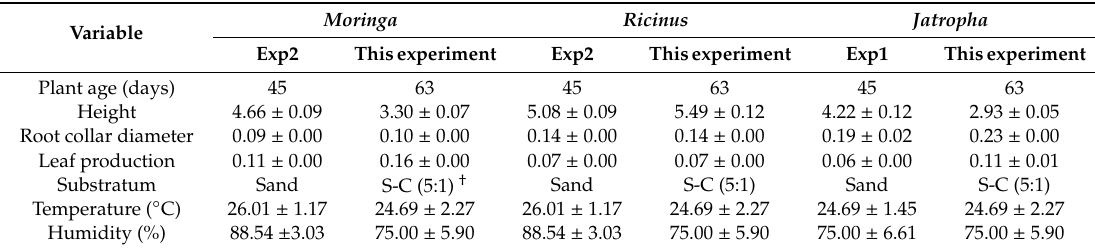
Table 2. Mean growth rates (mm / day) and leaf production (leaf / day) ± SE of Moringa oleifera , Jatropha curcas , and Ricinus communis , and environmental conditions registered in this and previous experiments conducted at the experimental site.